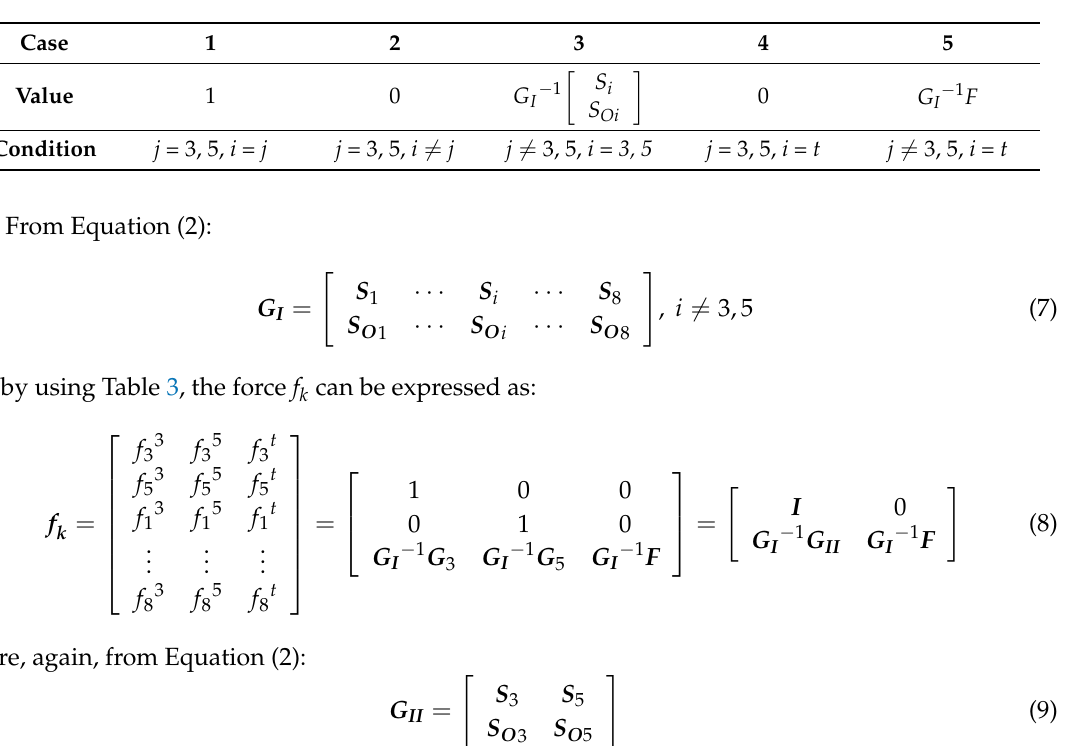
Table 3. Cases for force f j i on the measurement